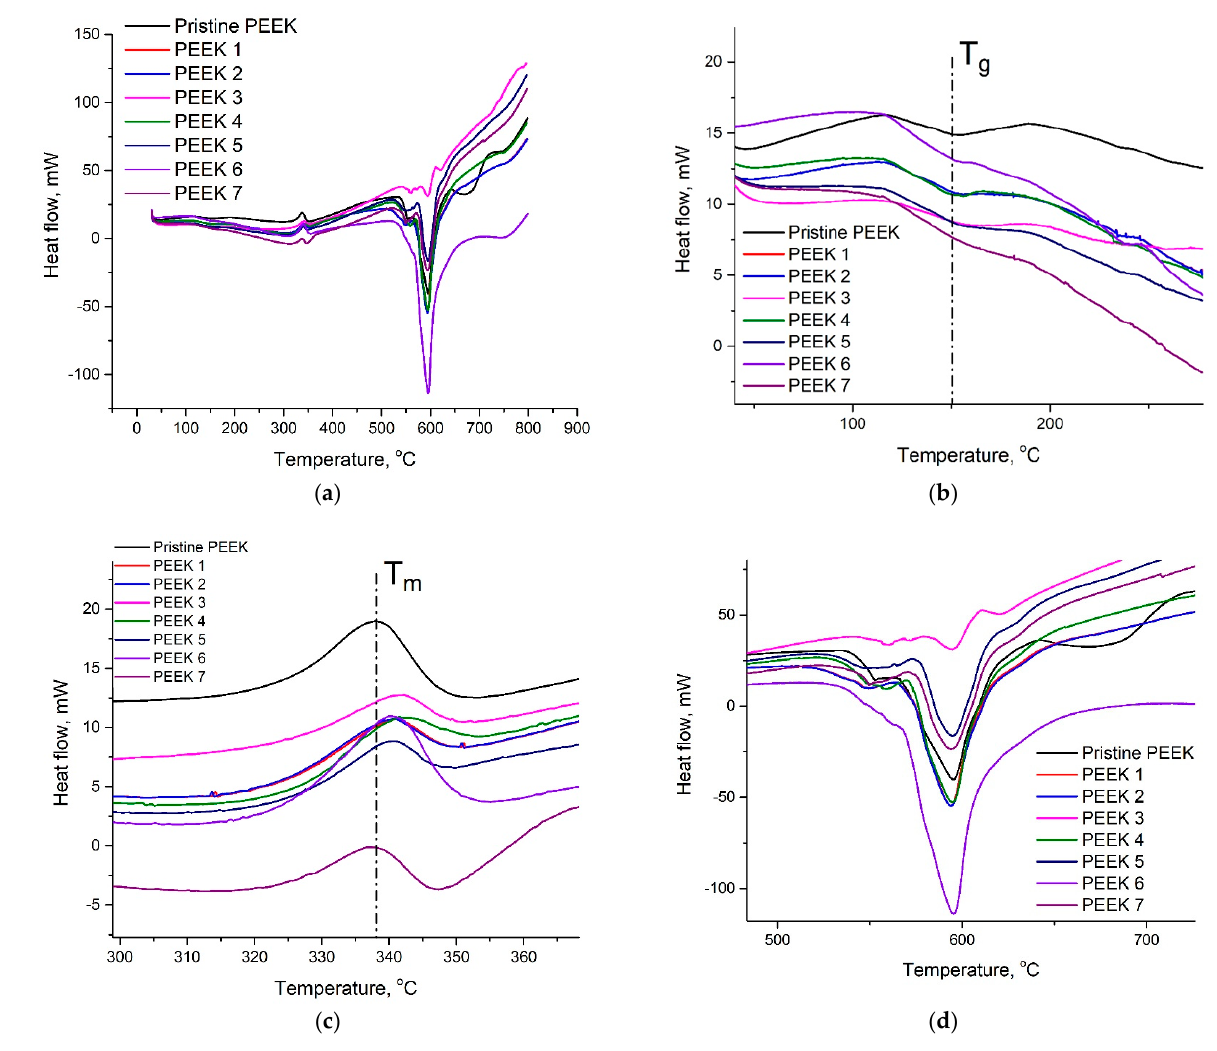
Figure 7. TGA curves of the pristine and irradiated PEEK samples.